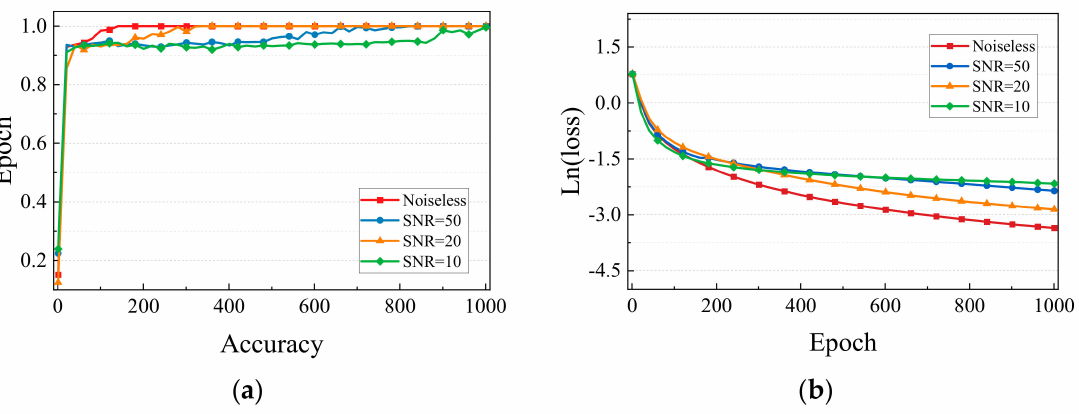
Figure 17. The training process of different SNR: ( a ) the accuracy of different SNR; ( b ) the ln(loss) of different